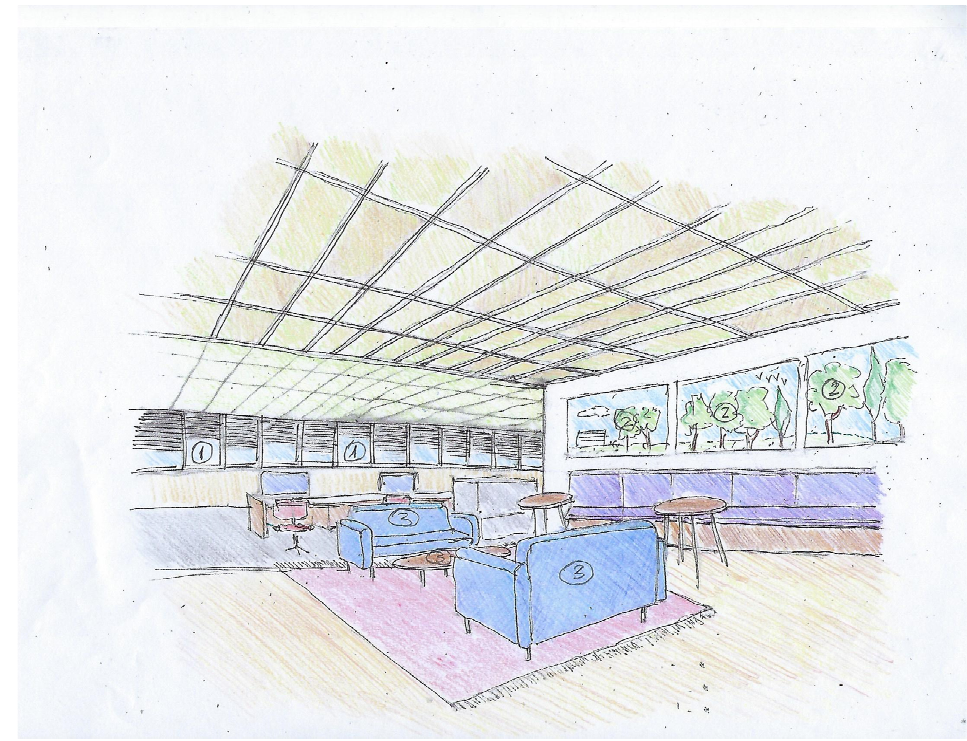
Figure 11. Sketch of an architectural design illustrating the use of controlled daylight ① , walls with images of pastoral views ② , and furniture arrangements to create a homey atmosphere ③ .